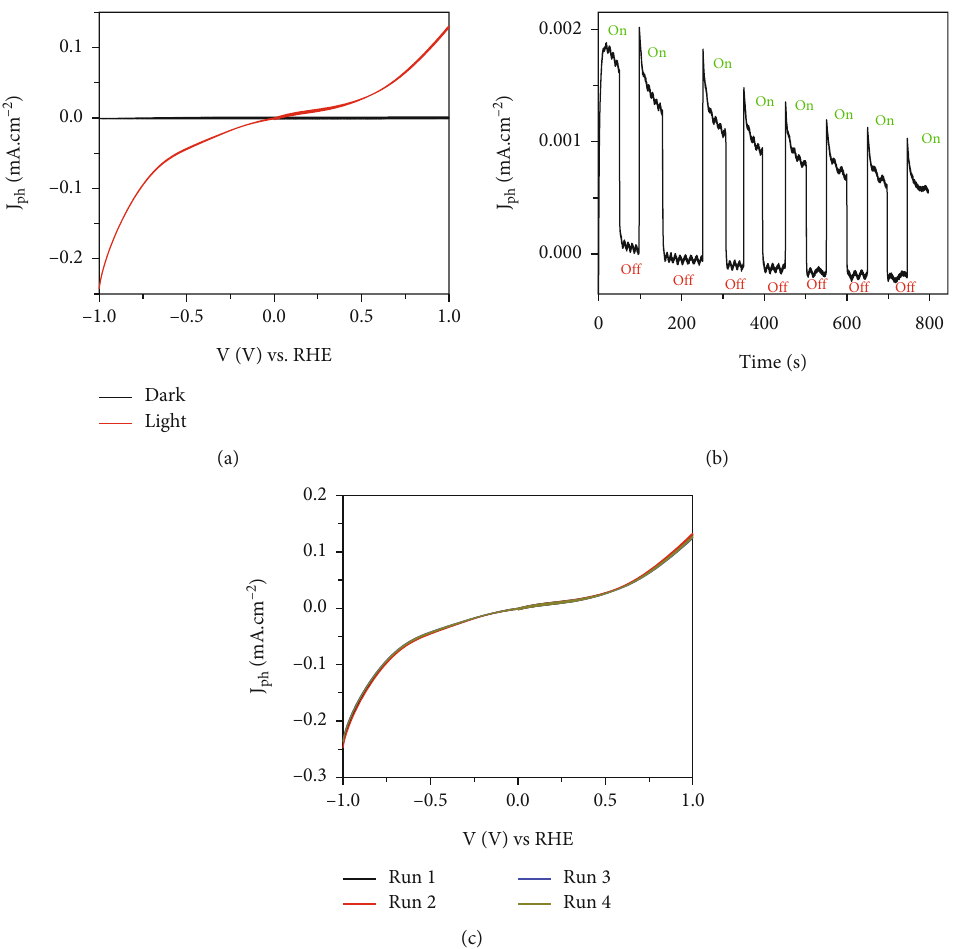
Figure 4: The e ff ect of (a) dark and light, (b) on/o ff chopped light, and (c) reproducibility on the ATO/PANI/PbS photoelectrode.